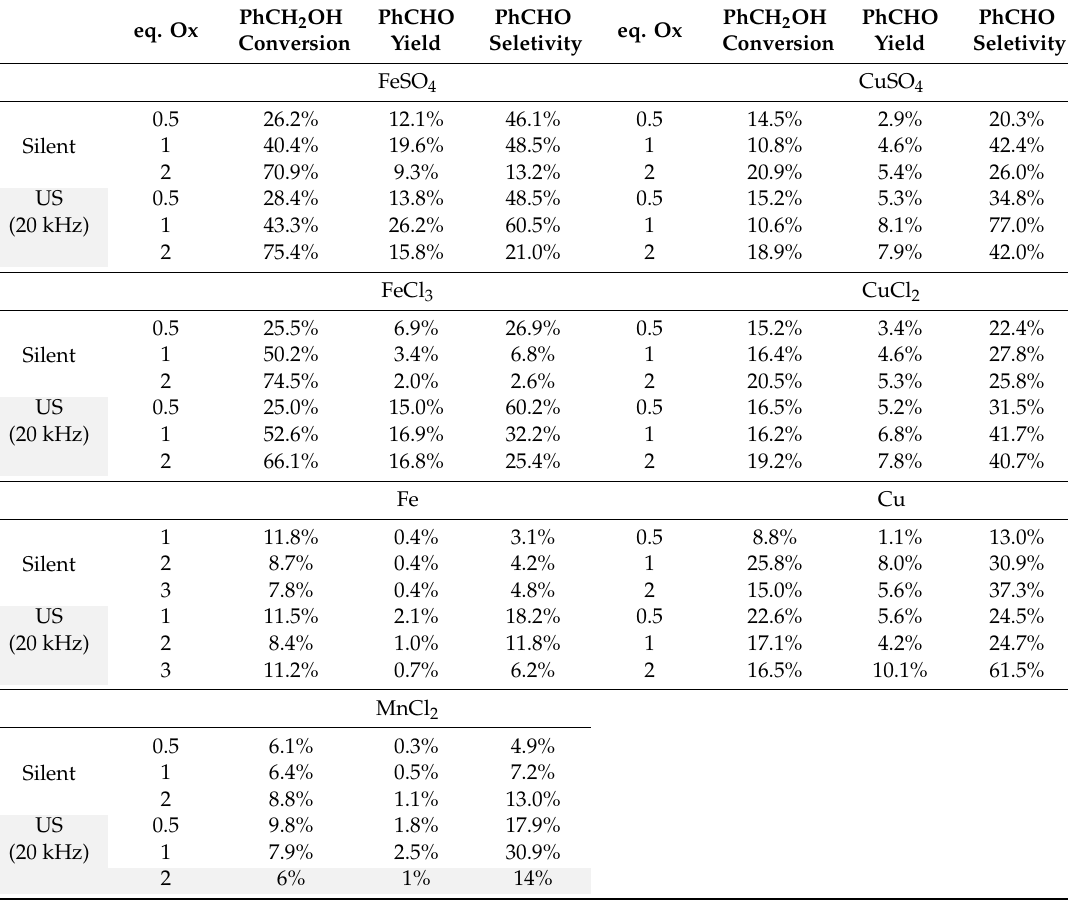
Table 3. Oxidation of PhCH 2 OH according to nature of the catalyst and H 2 O 2 concentration in